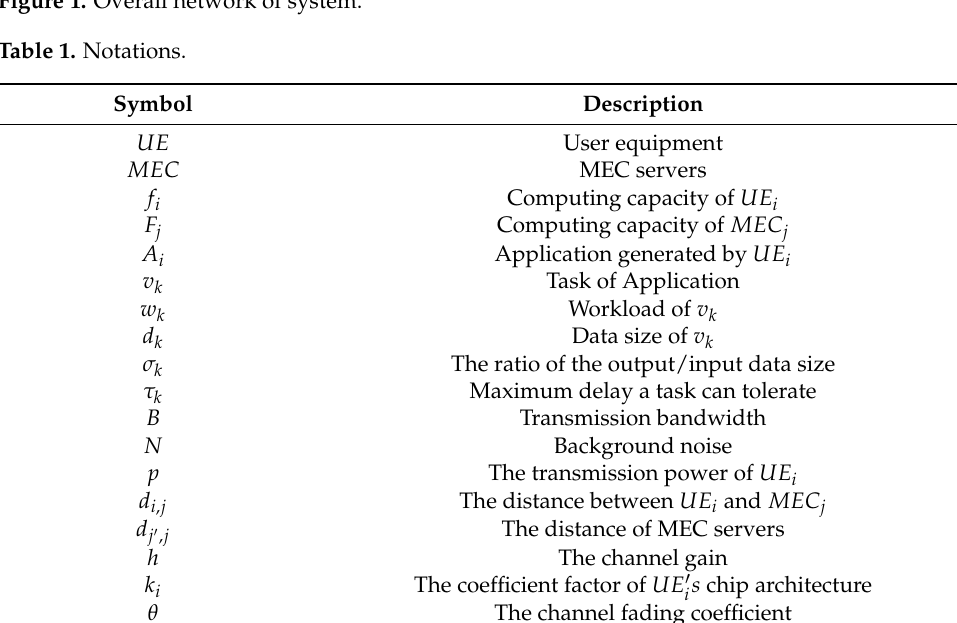
Figure 1. Overall network of system.